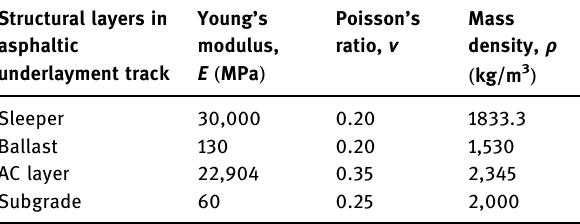
Table 2: Material properties of asphaltic underlayment track Structural layers in asphaltic underlayment track